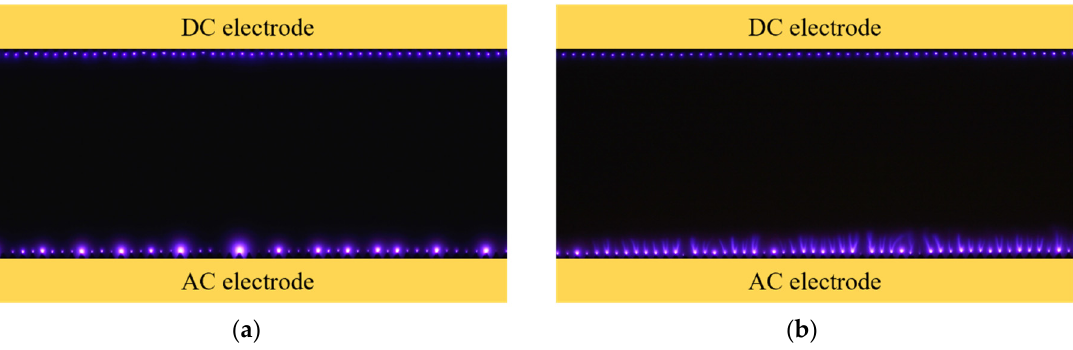
Figure 17. Discharge photographs in the case where a voltage of 10 kV pp at 2 kHz was applied to the AC electrode, and a voltage of 14 kV was applied to the DC electrode, in the ( a ) CD-PA and ( b ) TED-PA.